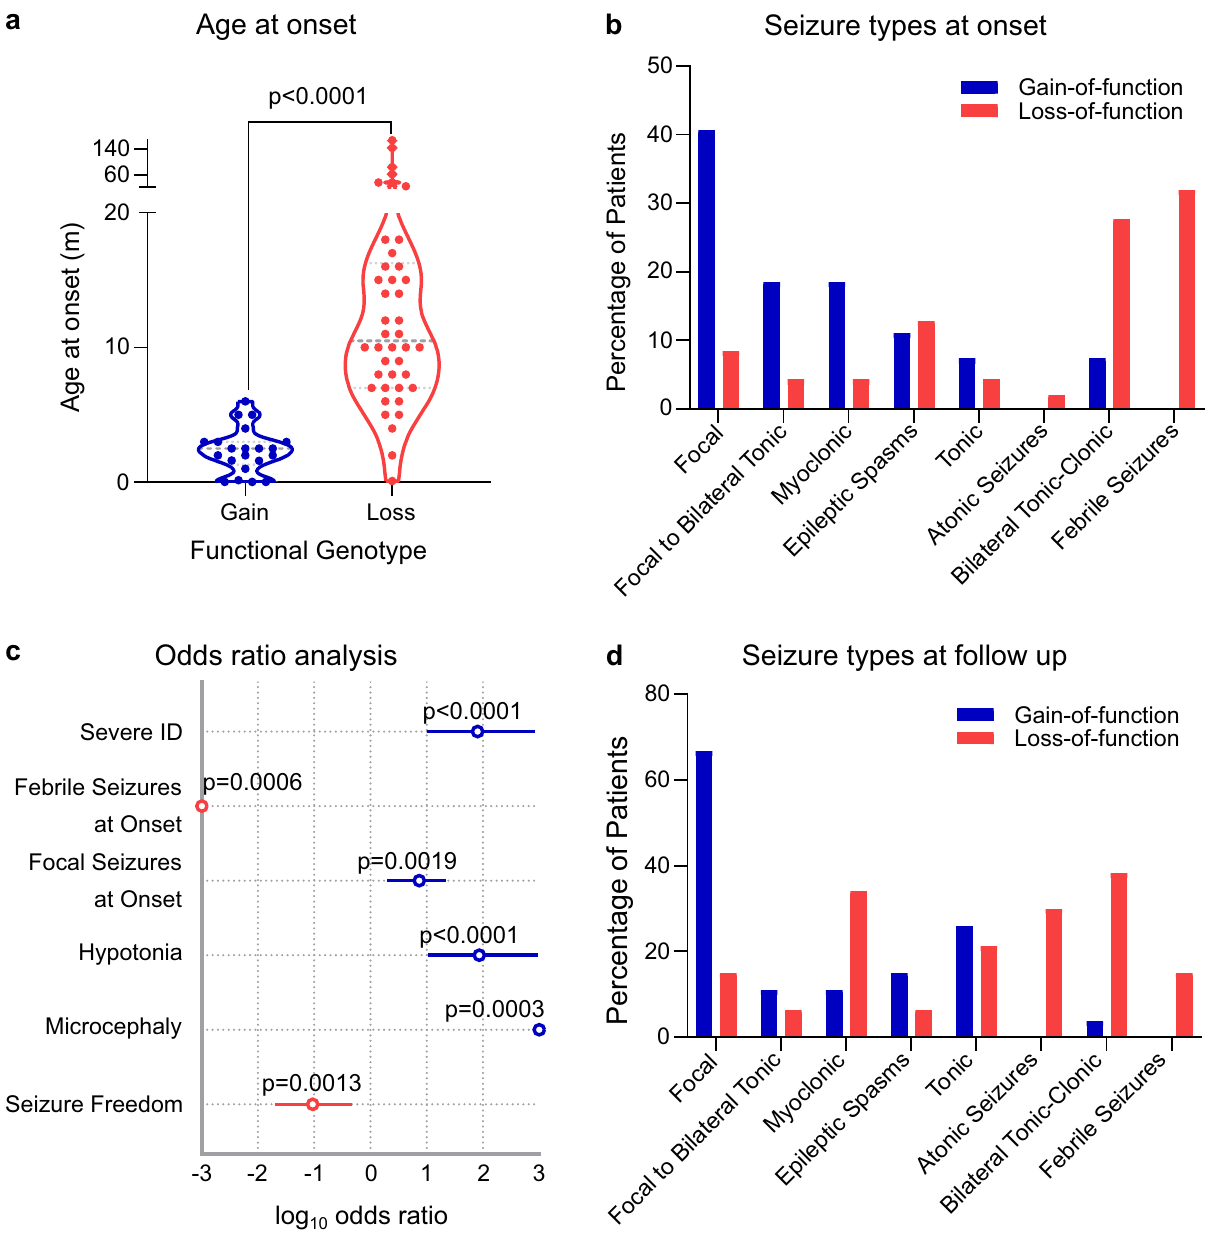
Fig. 4 Clinical features of patients harbouring a LOF or GOF GABRB3 variant. a Violin plot of age of seizure onset at gain-of-function (blue; n = 21 patients) and loss-of-function (red; n = 43 patients) variants. Dots represent individual data points, dotted lines represent median and quartiles. Two-sided unpaired Mann – Whitney U test, p = 1.1 × 10 − 11 , U = 39). b Selected seizure types reported at onset for patients with gain-of-function (blue bars) and loss- of-function (red bars) variants. Percentage of patients reporting each seizure type is shown. c Odds ratio of key clinical outcomes in gain-of-function vs . loss- of-function variants with the centre circle showing the log 10 odds ratio and 95 % con fi dence interval. Blue indicates signi fi cant enrichment in gain-of-function variants, and red indicates signi fi cant enrichment in the loss-of-function variants. For each indication, the total number of patients reporting were n = 18, 27, 27, 16, 11 and 19 gain-of-function patients, and n = 40, 47, 47, 27, 24 and 36 loss-of-function patients for severe intellectual disability, febrile seizures, focal seizures, hypotonia, microcephaly and seizure freedom, respectively. Fisher ’ s exact test, two-sided, p = 2.7 × 10 − 8 , 2 × 10 − 5 , 0.019, 3.5 × 10 − 7 , 3 × 10 − 4 and 0.013, respectively. d Selected seizure types reported at follow-up for patients with a gain-of-function (blue bars) and loss-of-function (red bars) variants. Percentage of patients reporting each seizure type is shown. Source data are provided in the supplementary information (Supplementary Table